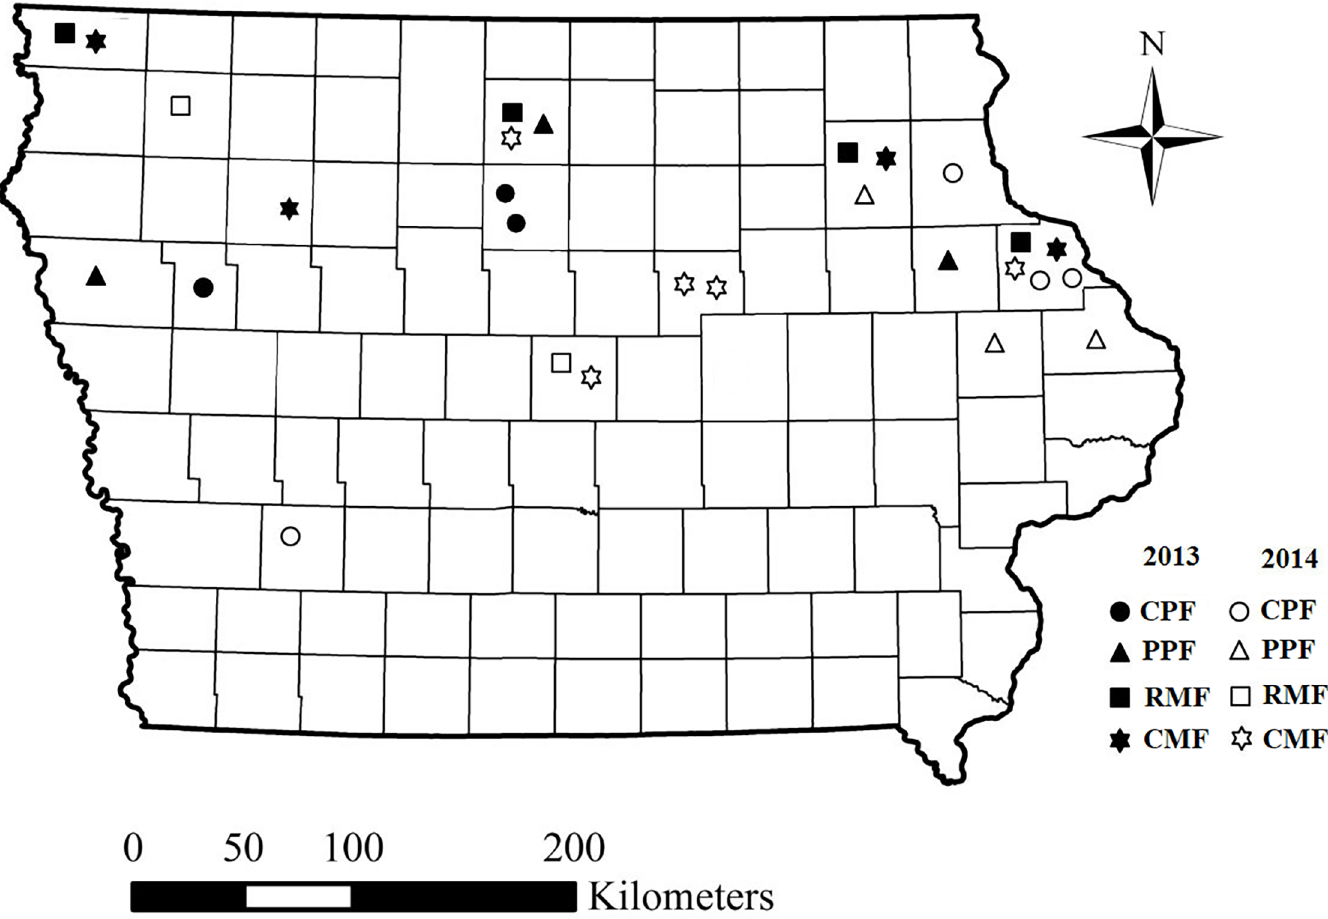
Fig 1. Location of western corn rootworm populations tested in plant-based bioassays. The map represents the state of Iowa, USA and individual sections of the map are counties in Iowa. Symbols represent individual fields that were sampled for adult western corn rootworm and subsequently tested in bioassays. Field locations are accurate to the level of an individual county. CPF = current problem field, PPF = past problem field, RMF = rotated maize field, and CMF = continuous maize field.